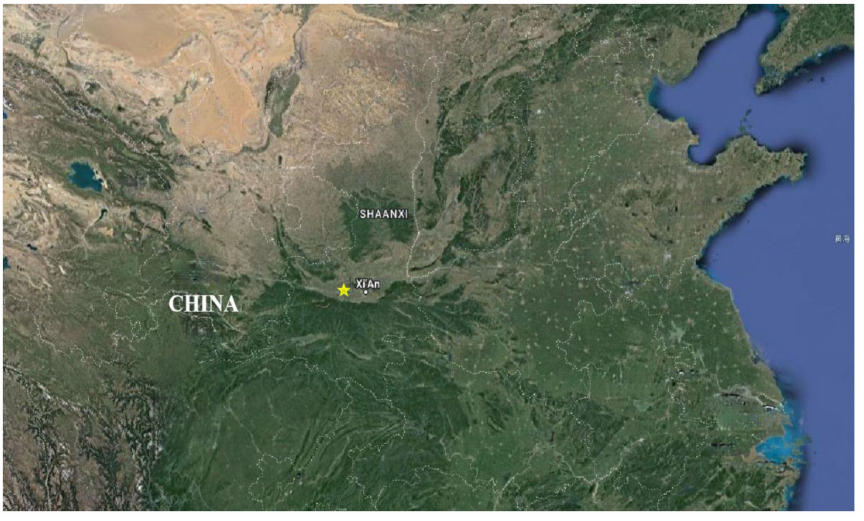
Figure 1. Test location